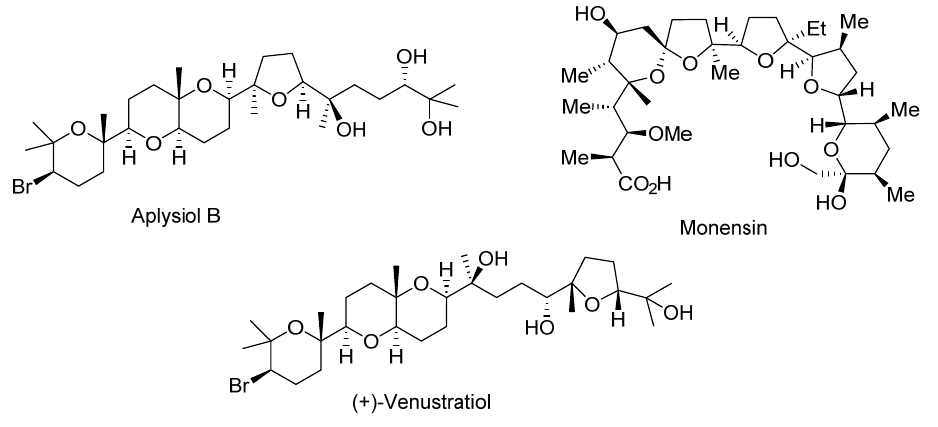
Figure 1. Polyether natural products.